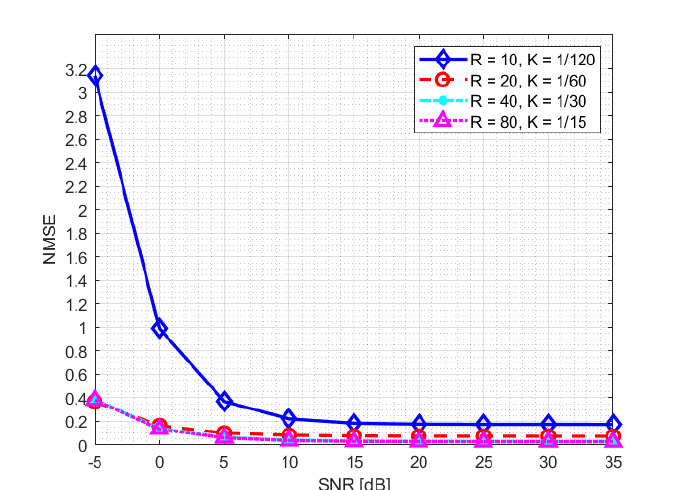
Figure 7. NMSE statistics for NR-CsiNet model trained at SNR = 20 dB.